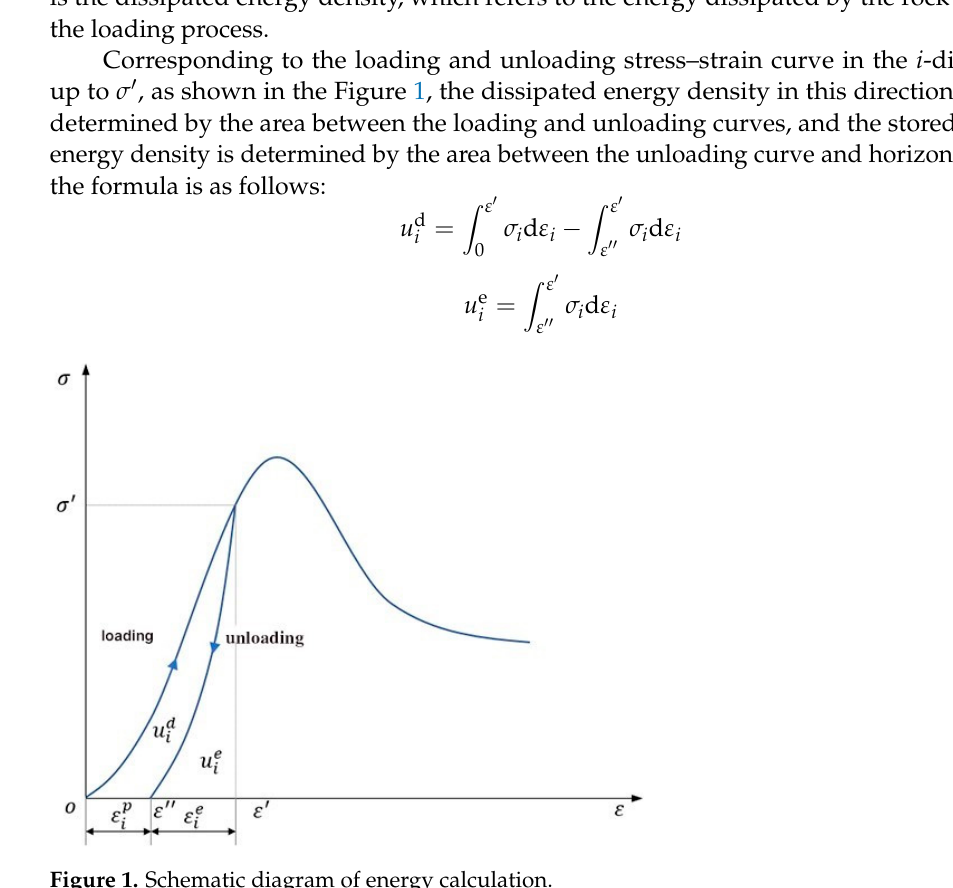
Figure 1. Schematic diagram of energy calculation.